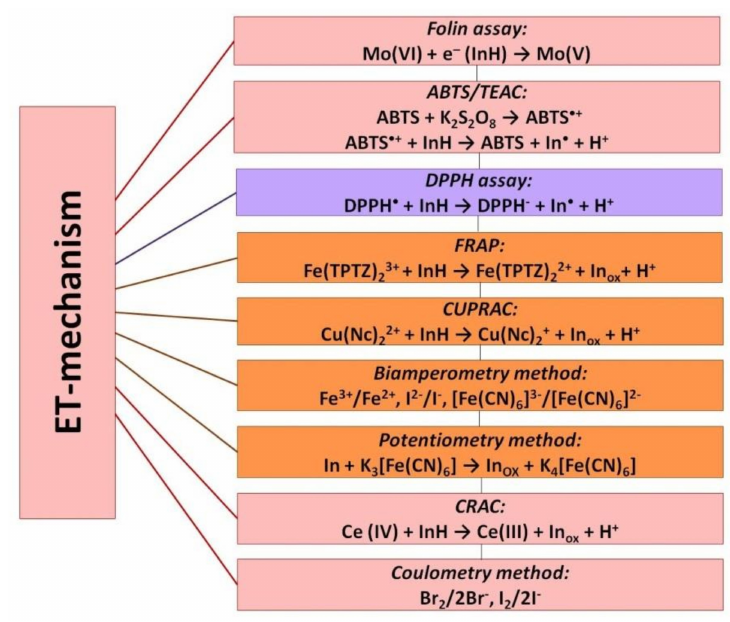
Figure 3. Electron-transfer-based